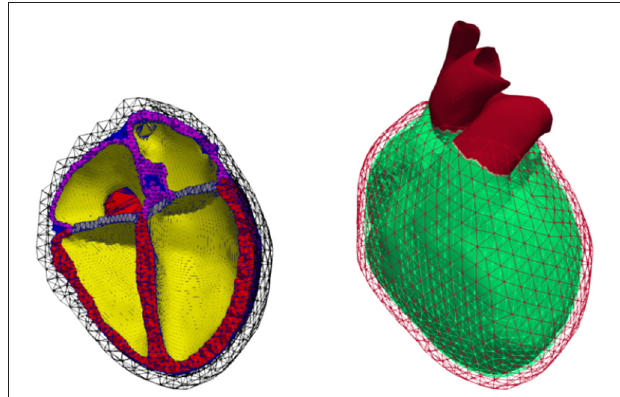
FIGURE 3 | Volumetric geometry used for continuum mechanics. Left: Cut open mesh used to calculate deformation; cavities (yellow), ventricular walls (red), atrial walls (purple), fat (green), valves (blue), non-cardiac tissue (black mesh). Right: Representation of the Dirichlet boundary condition marked in red comprising the outer layer of the surrounding non-cardiac tissue as well as all blood vessels protruding that